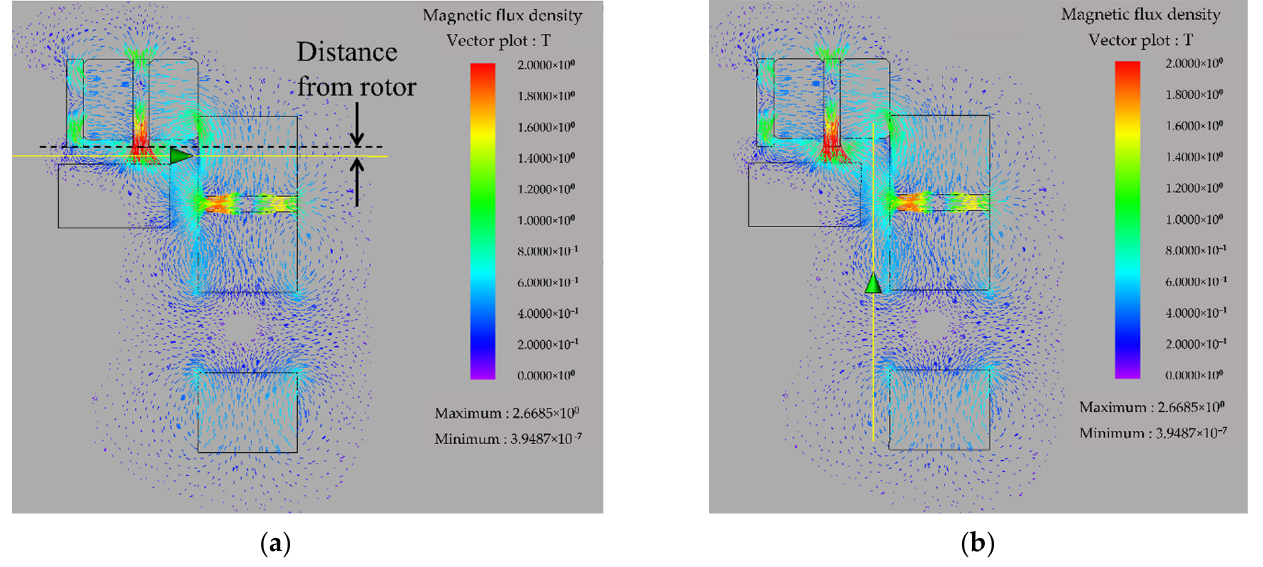
Figure 5. Magnetic flux density data extraction position shown by numerical analysis: ( a ) Plot sec- tion line at top of HTS, ( b ) Plot section line at side of HTS.